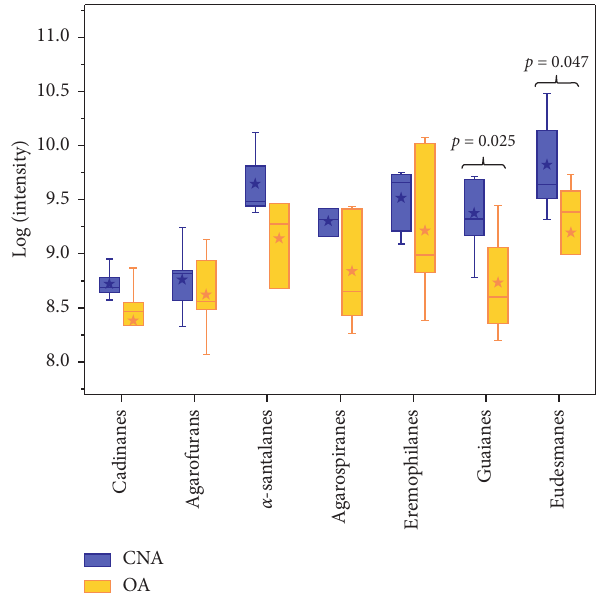
Figure 5: Comparison of sesquiterpenes in different configurations between the CNA (colored blue) and OA (colored yellow) (the stars on the boxes represent mean values of different types of sesqui- terpenes). The stars on the boxes represent mean values. The median is drawn as a black horizontal line inside the